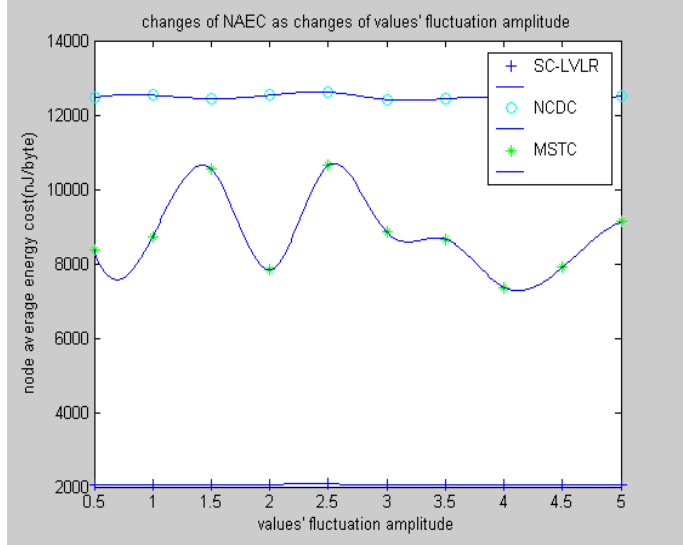
Figure 6. Changes of NAEC with changes of values’ fluctuation